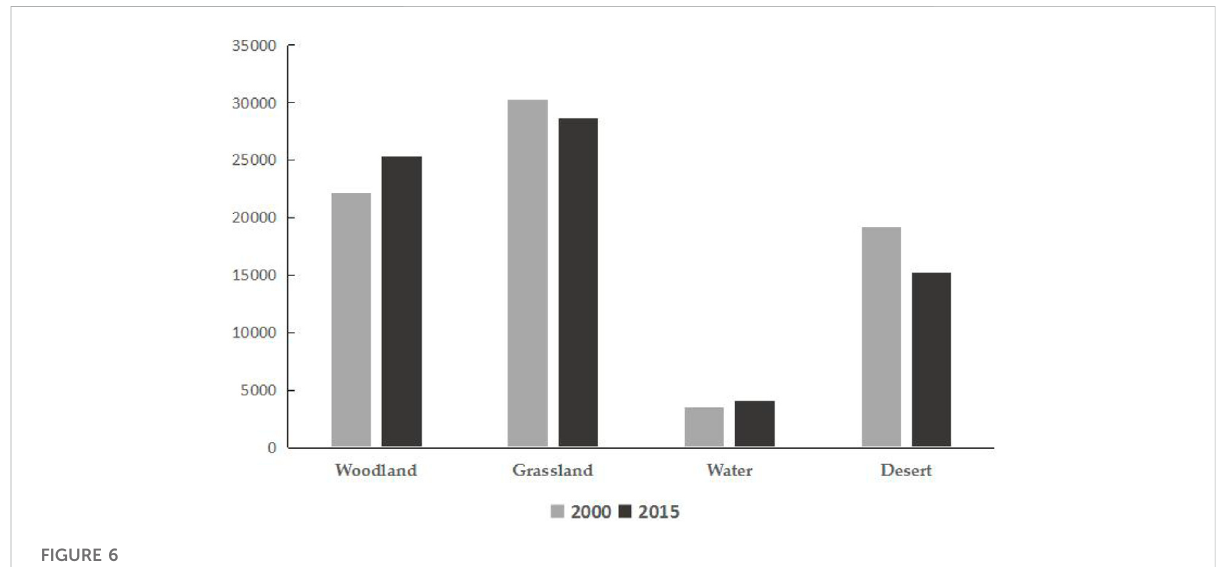
FIGURE 6 Area change of China ’ s ecological space in 2000 and 2015.